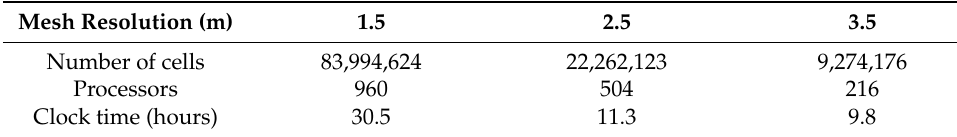
Table 3. Mesh independence test on NREL 5